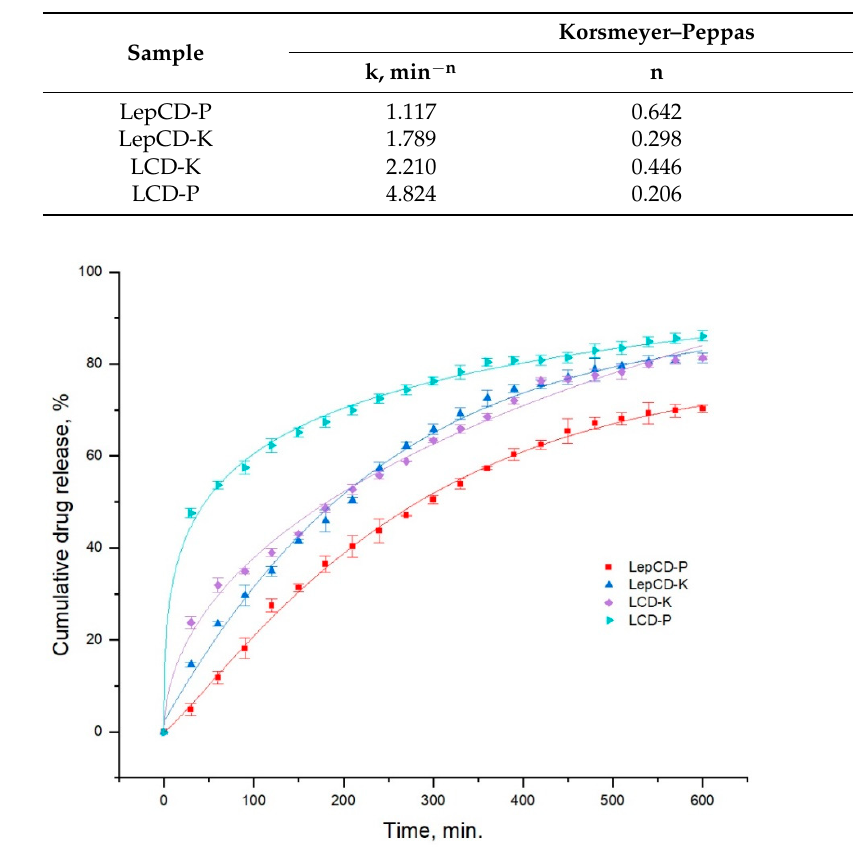
Table 3. The kinetic parameters for drug release experiments.